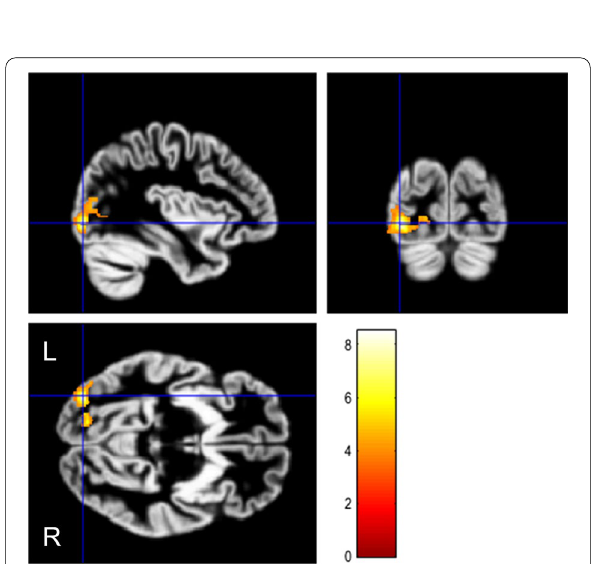
Fig. 4 VBM analysis with small volume correction restricted to the occipital lobe, showing the increase of gray matter volume in visual snow syndrome (VSS) patients compared to CON. SPM displayed at p height < 0.001 uncorrected and K ext > 200 voxels. Clusters are overlaid onto the average GM from the whole study population. Significance is shown with a T statistic color scale. Images are in neurological